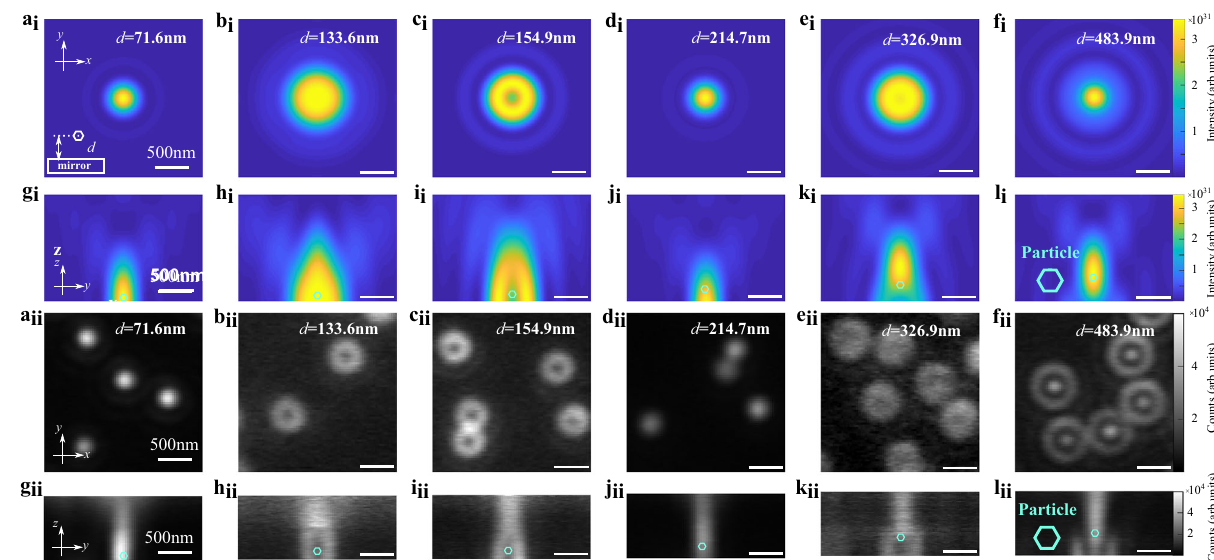
Fig. 2 Comparison of simulated and experimental distance-dependent far- fi eld PSFs of UCNPs ’ emission self-interference. The UCNP-to-mirror distance d (see inset in a i ) increases from the left to the right column as indicated from 71.6 to 483.9 nm. The simulated PSFs of the self-interference for a particle on a mirror substrate with spacing distances of 71.6, 140, 154.9, 214.7, 326.9, and 483.9nm, at the x - y plane ( a i – f i ) and y - z plane ( g i – l i ). The experimentally measured PSFs of the upconversion emission self-interference for UCNPs on a mirror substrate with the distance of 71.6, 133.6, 154.9, 214.7, 326.9, and 483.9 nm away from the mirror surface, at the x - y plane ( a ii – f ii ) and y - z plane ( g ii – l ii ). a ii – f ii Recorded by imaging the UCNPs at the x - y plane. g ii – l ii Recorded by stacking defocused x-y plane images. The radius of the UCNPs was 16.5 nm, and the emission wavelength used for detection is at 455 nm. A defocused 980 nm laser creates the wide fi eld excitation. More experimental and simulation results for 455 and 800nm emission wavelengths are shown in Supplementary Figs. 11 and 12, respectively. The scale bar is 500 nm. The imaging focal plane in a i – f i and a ii – f ii is at z = 0, where the UCNP is located. Experimentally the z = 0 plane is determined by moving the focus above the mirror surface with spacing distance. The z position of the mirror surface is located by the re fl ection of a Gaussian beam. The tiny cyan hexagon indicates the z - y plane position of the UCNPs, where z = 0 and y = 0. The experiment results were captured by an EMCCD with an exposure time of 20 ms. The experimental PSFs at the z - y plane is the cross-section images of a 3D volume image generated by stacking 160 defocused images (20 nm for step size) at the x - y plane. The defocusing is well-de fi ned and achieved by the objective ’ s piezoelectric positioner. The surrounding medium of UCNPs is the immersion oil with a refractive index of 1.5. All scale bars in this fi gure are 500